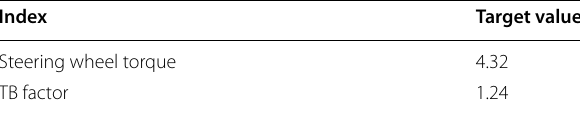
Table 4 Optimization